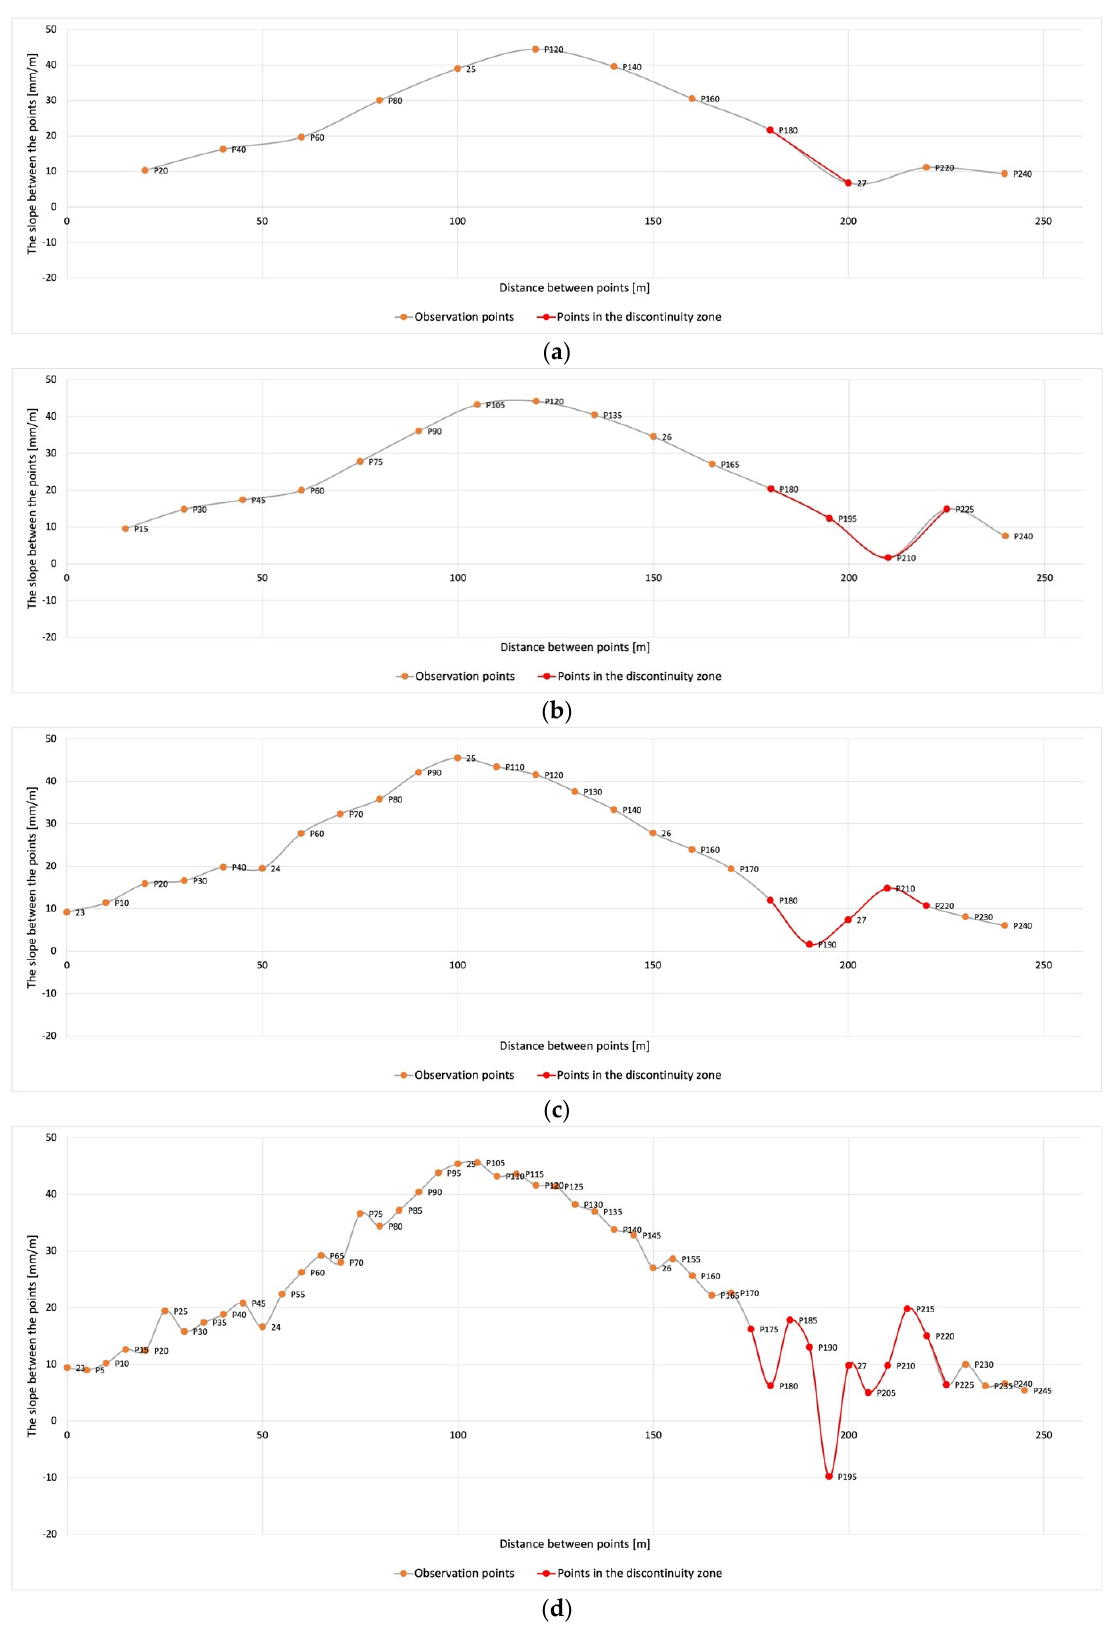
Figure 18. Slope (T) graphs between measurement points at a distance of ( a ) 20 m, ( b ) 15 m, ( c ) 10 m and ( d ) 5 m.